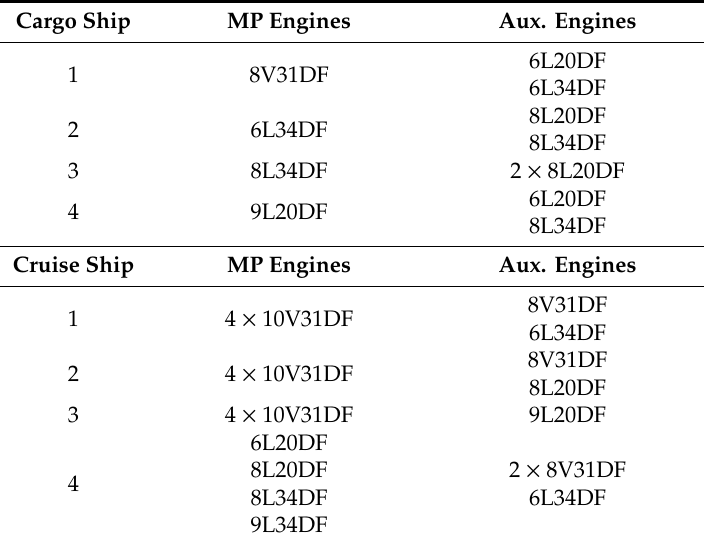
Table 11. Multi-objective optimization, installed